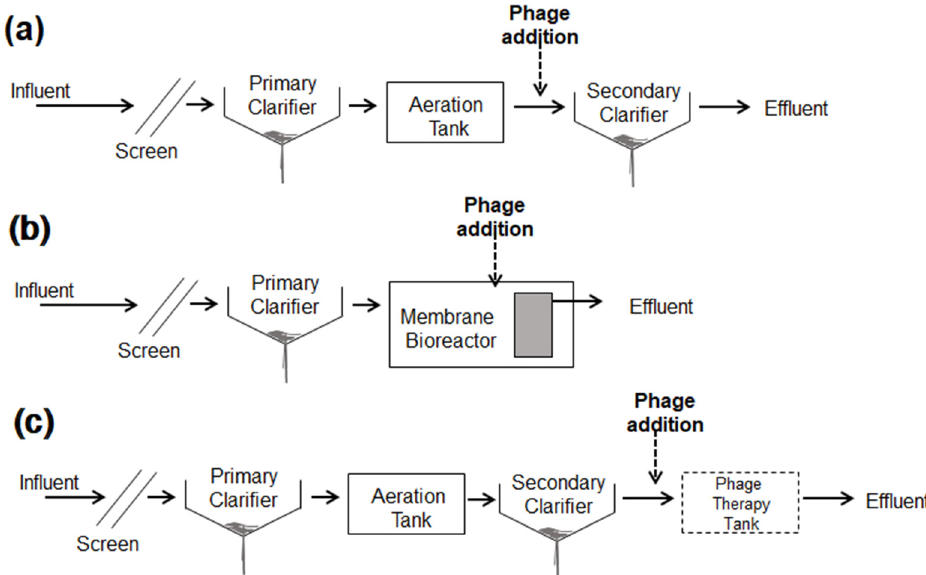
Figure 7. Potential location of phage dose in wastewater treatment processes. ( a ) Conventional activated sludge process, ( b ) membrane bioreactor, and ( c ) conventional activated sludge process with optional reservoir of phage treatment.